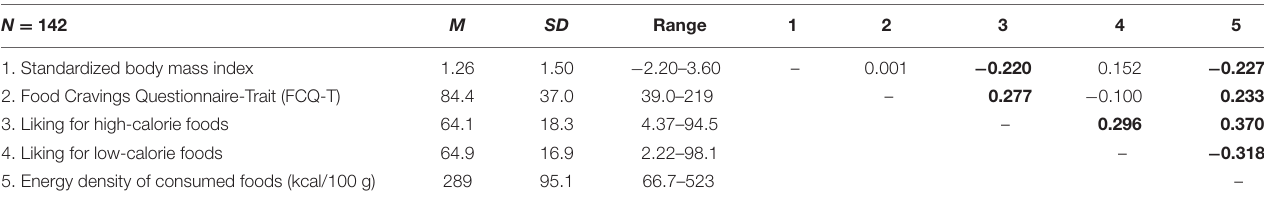
TABLE 1 | Descriptive statistics of and correlations between study